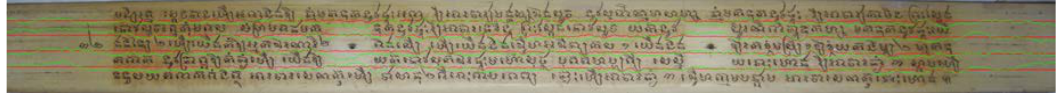
Figure 23. Text line segmentation of Balinese manuscript with the Seam Carving method (green) and Adaptive Path Finding (red).